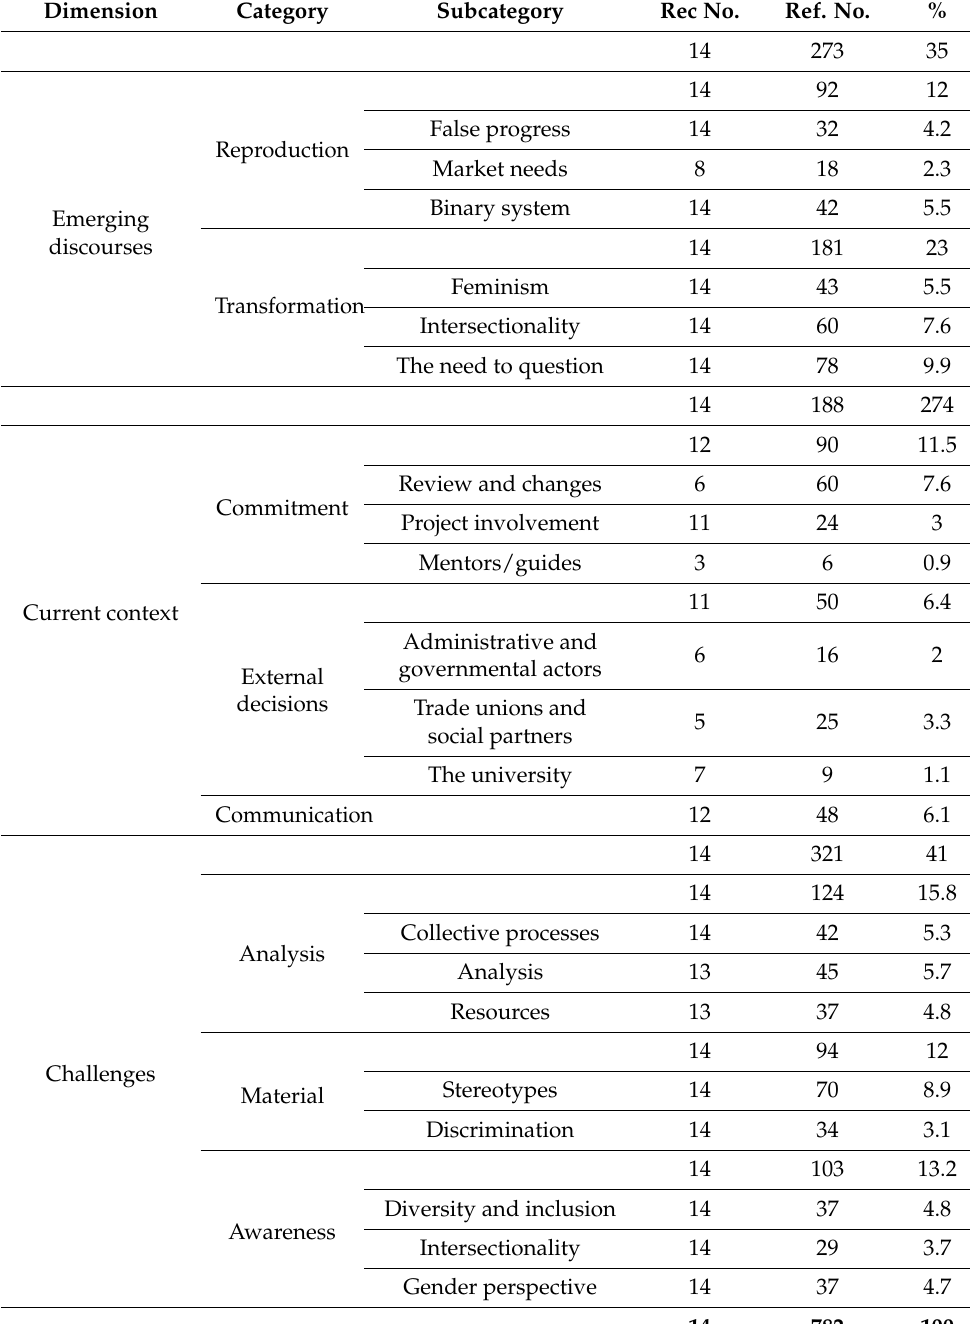
Table 2. Categorical system and number of